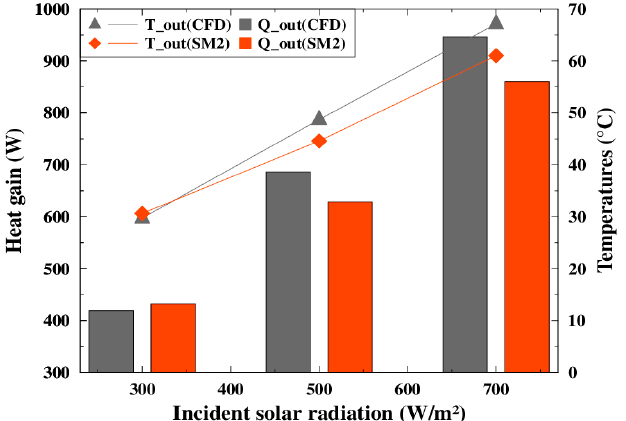
Figure 15. Variation in the temperature and heat gain of the air at the outlet with incident solar radiation.